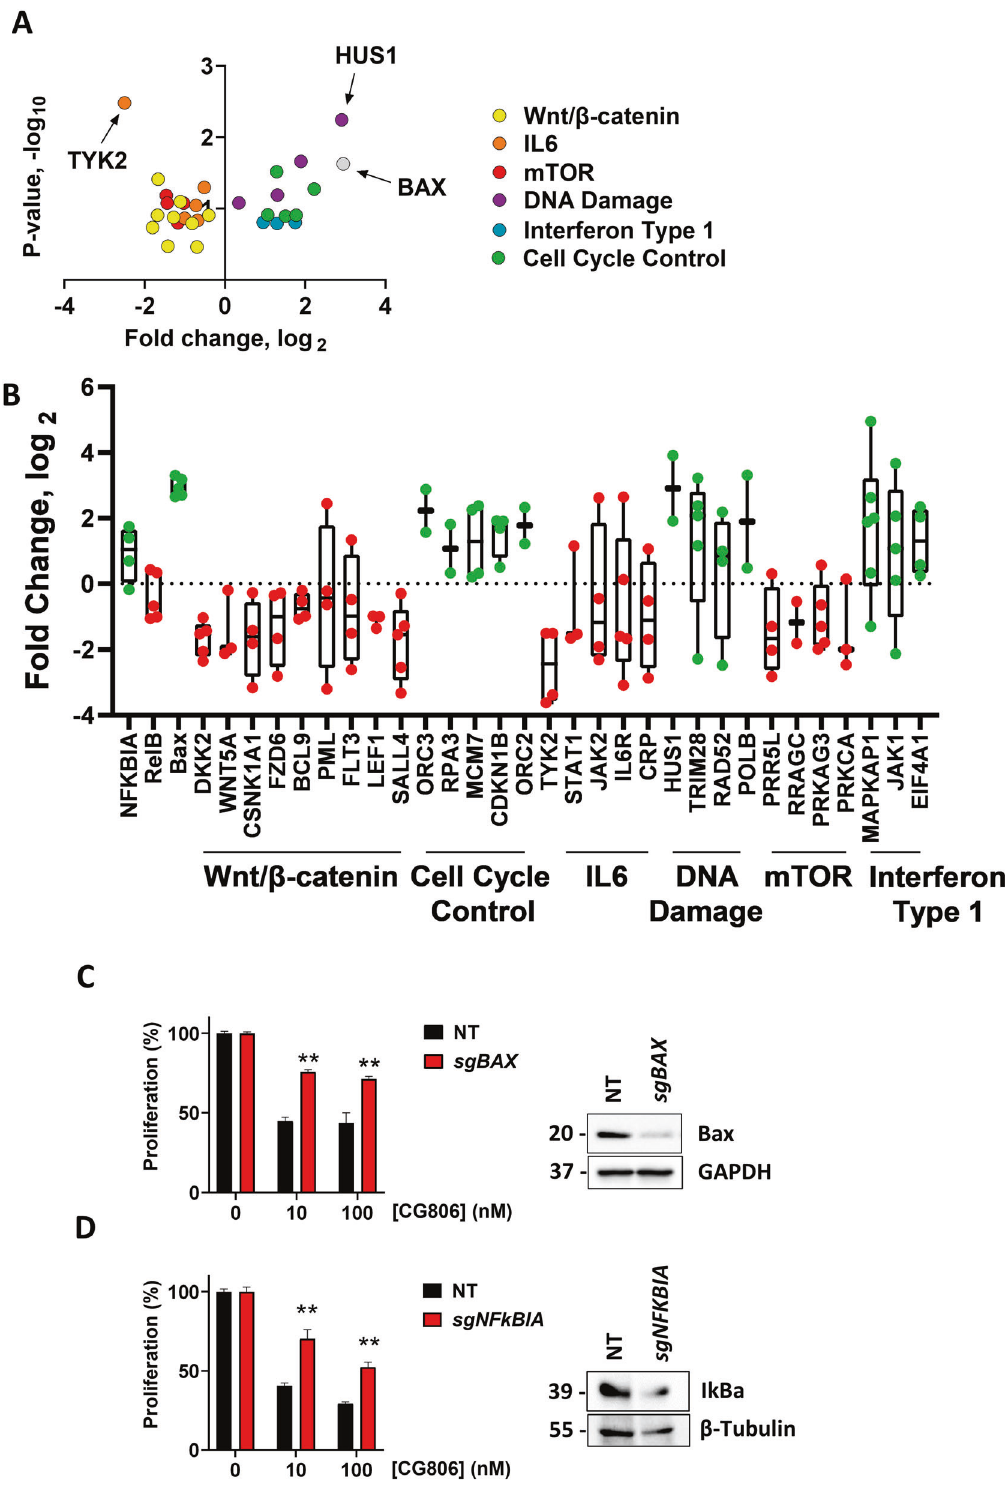
Fig. 5 Genome-wide CRISPR-Cas9 library screen implicates BAX and NFKBIA loss in resistance to CG-806. Genome-wide loss of function CRISPR library screening was carried out in OCI-LY3 cells as described in the methods. Data were analyzed using a MaGeCK pipeline analysis. A Volcano plot of mid fold change vs. mid p value of all sgRNA per gene in select genes grouped by the association in pathways identi fi ed using webgestalt software. Highly differential and signi fi cant genes are identi fi ed with black arrows. B Box and whisker plot spanning min/ max fold change of CG-806 vs control with individual sgRNA per gene depicted as points. Genes for which a majority of sgRNA demonstrate positive fold change are shown in green, negative in red. C , D BAX and NFKBIA knockout was established in Jeko-1 cells using RNP electroporation as described in the methods. Whole-cell lysates were subjected to immunoblotting. Cells were treated with CG-806 or vehicle control at the indicated concentrations for 48 h. Cell proliferation was assessed using a colorimetric tetrazolium-based assay. Mean±SE is shown. * p < 0.05 and ** p < 0.01 vs. NT